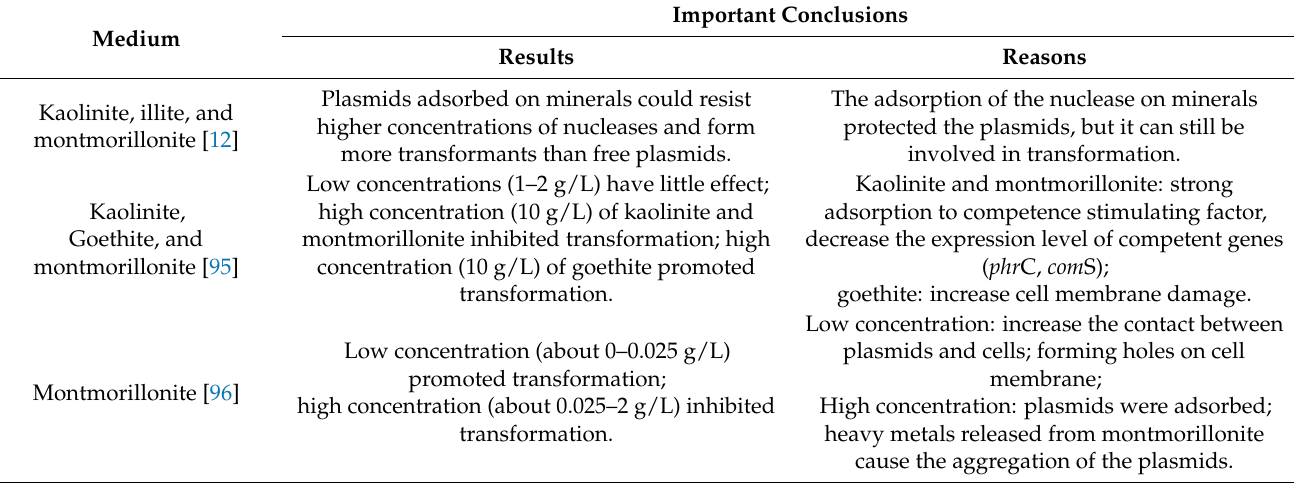
Table 4. Research on the effects of soil components on transformation of antibiotic resistance genes